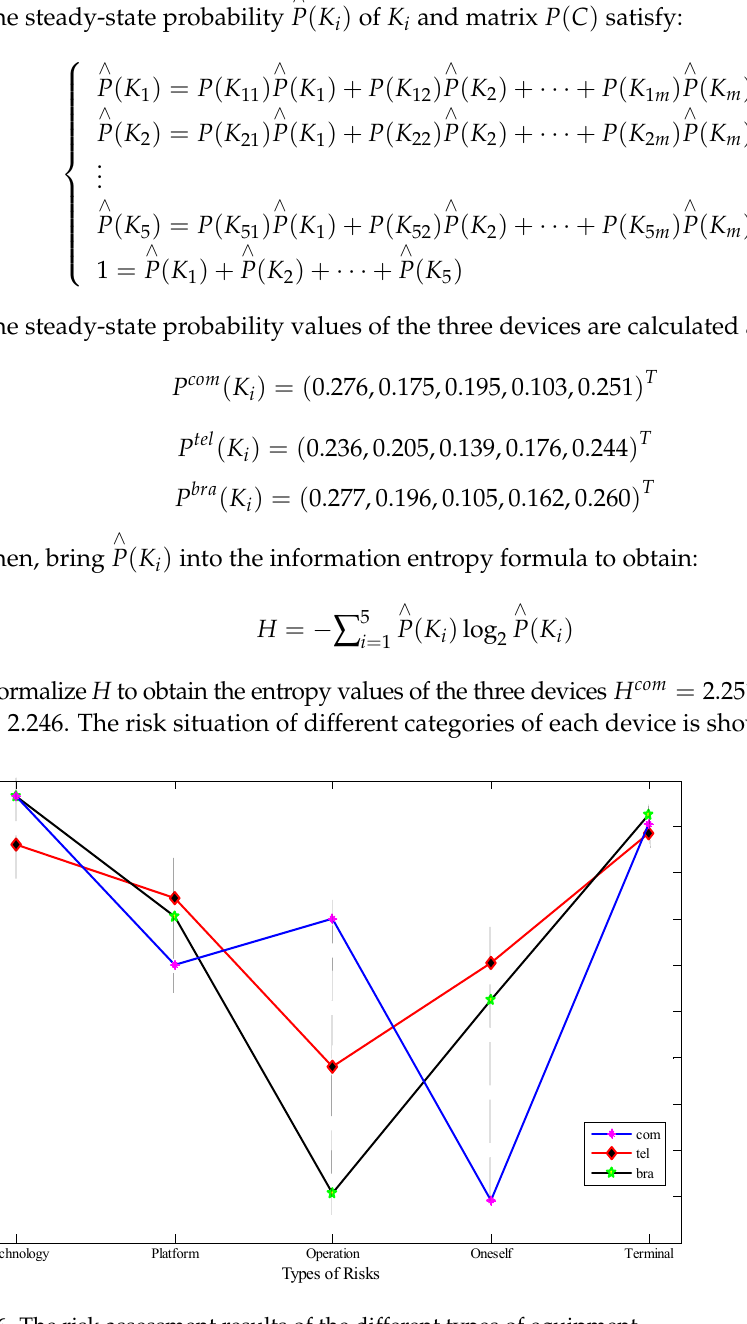
Figure 6. The risk assessment results of the different types of equipment. In Figure 6, the blue, red, and black lines, respectively, represent the entropy under each risk category of the tablet computer, smartphone, and bracelet. The ordinate represents the entropy value, and the abscissa represents the primary index of the dataset. First of all, tablet computers have the largest entropy at the technical level, followed by the terminal level, followed by the operation risk, platform, and self. The greater the entropy and the higher the uncertainty, the greater the possibility of information disclosure. Tablet computers are prone to privacy disclosure at the technical and terminal levels. Similarly, levels. Conversely, smartphones and bracelets are stable at the level of operation risk, which is not easy to cause information leakage, while tablets are stable at their own level. Overall information leakage risk: according to the entropy obtained by the above three devices, the overall information leakage risk of the three devices is almost the same. From a micro perspective,